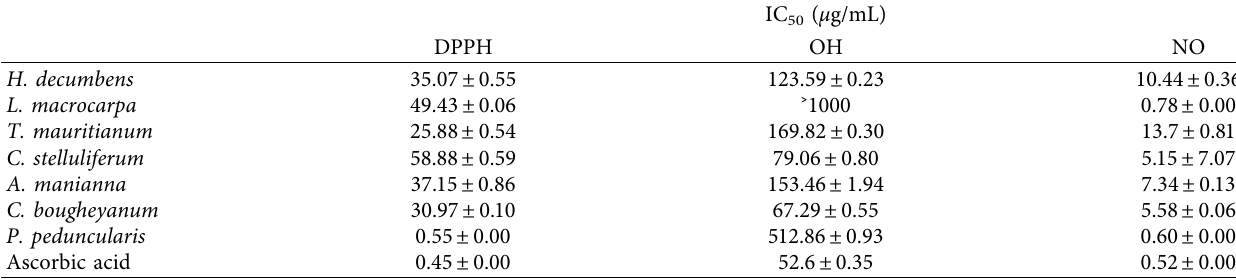
Table 3: IC 50 ( μ g/mL) values of seven medicinal plant extracts against DPPH, OH, and NO radical